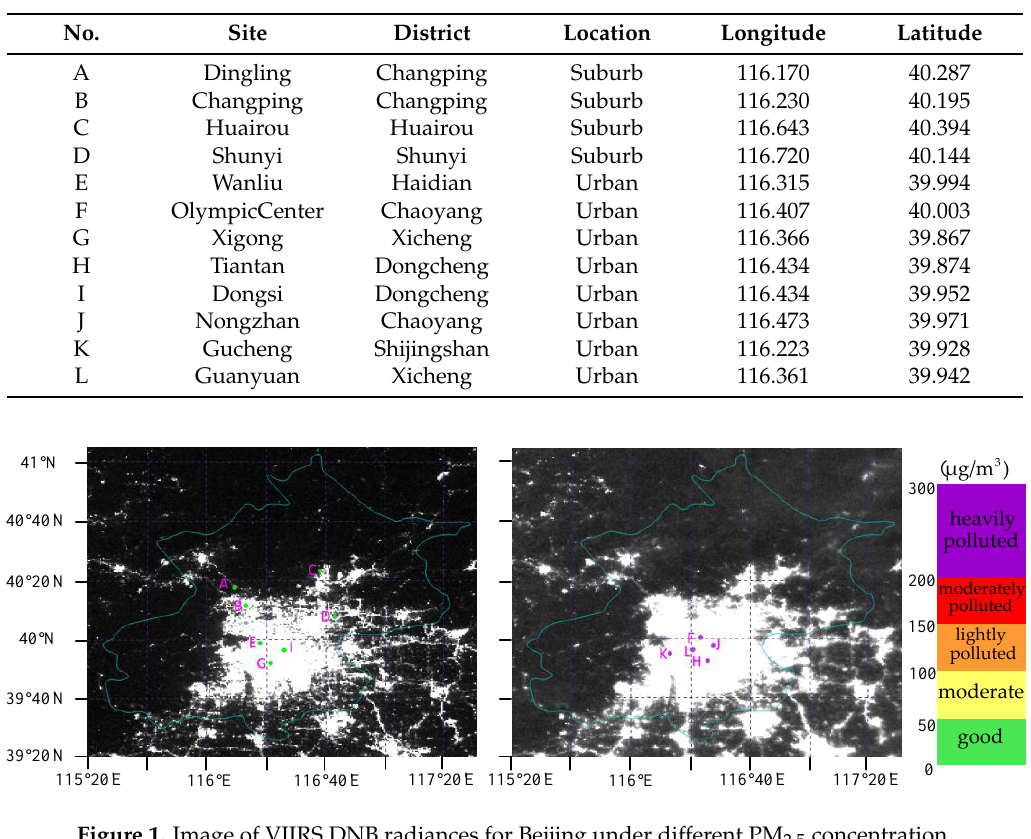
Figure 1. Image of VIIRS DNB radiances for Beijing under different PM 2.5 concentration.